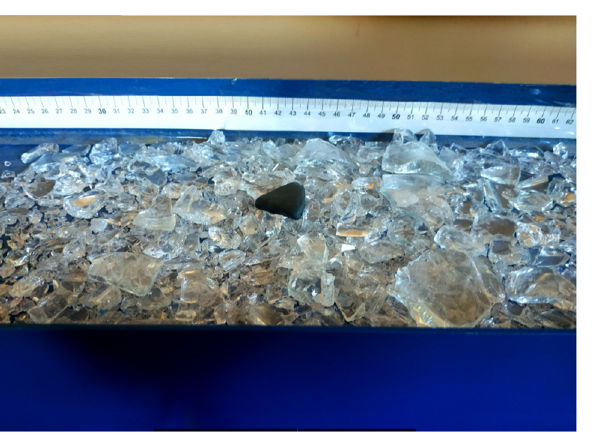
Figure 12: Experimental results of the feed transport.